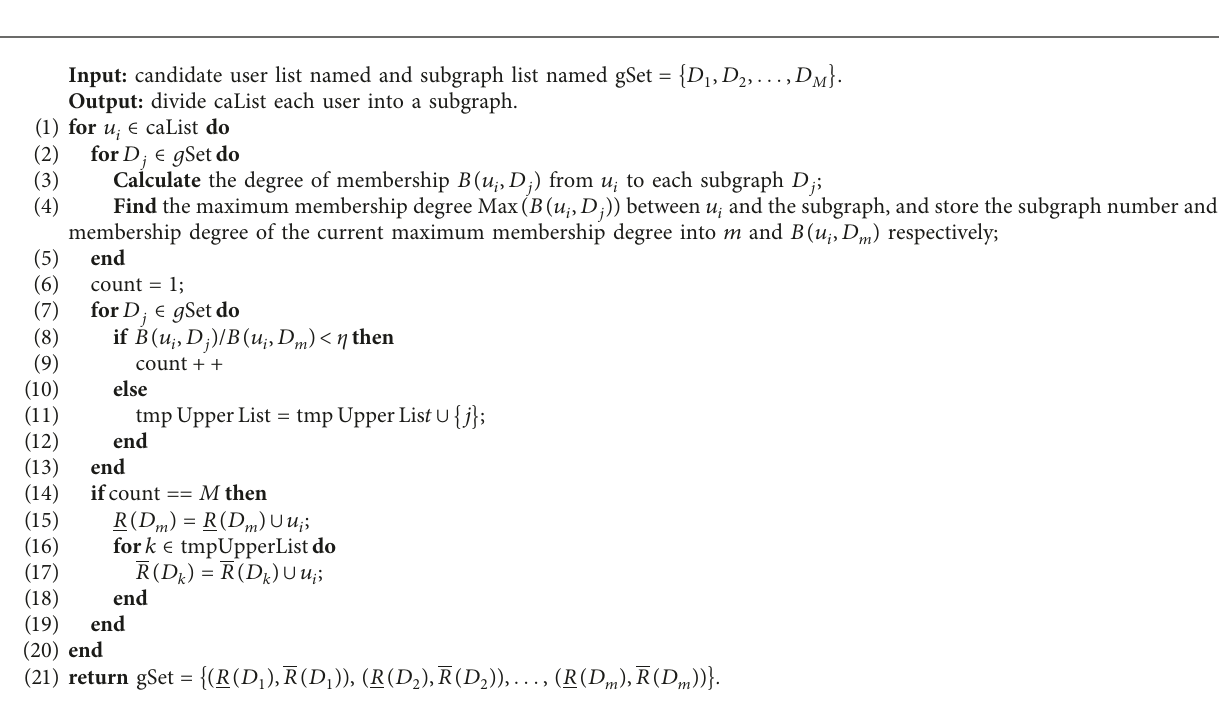
A LGORITHM 2: Algorithm for dividing upper and lower approximations of subgraph based on the central node named